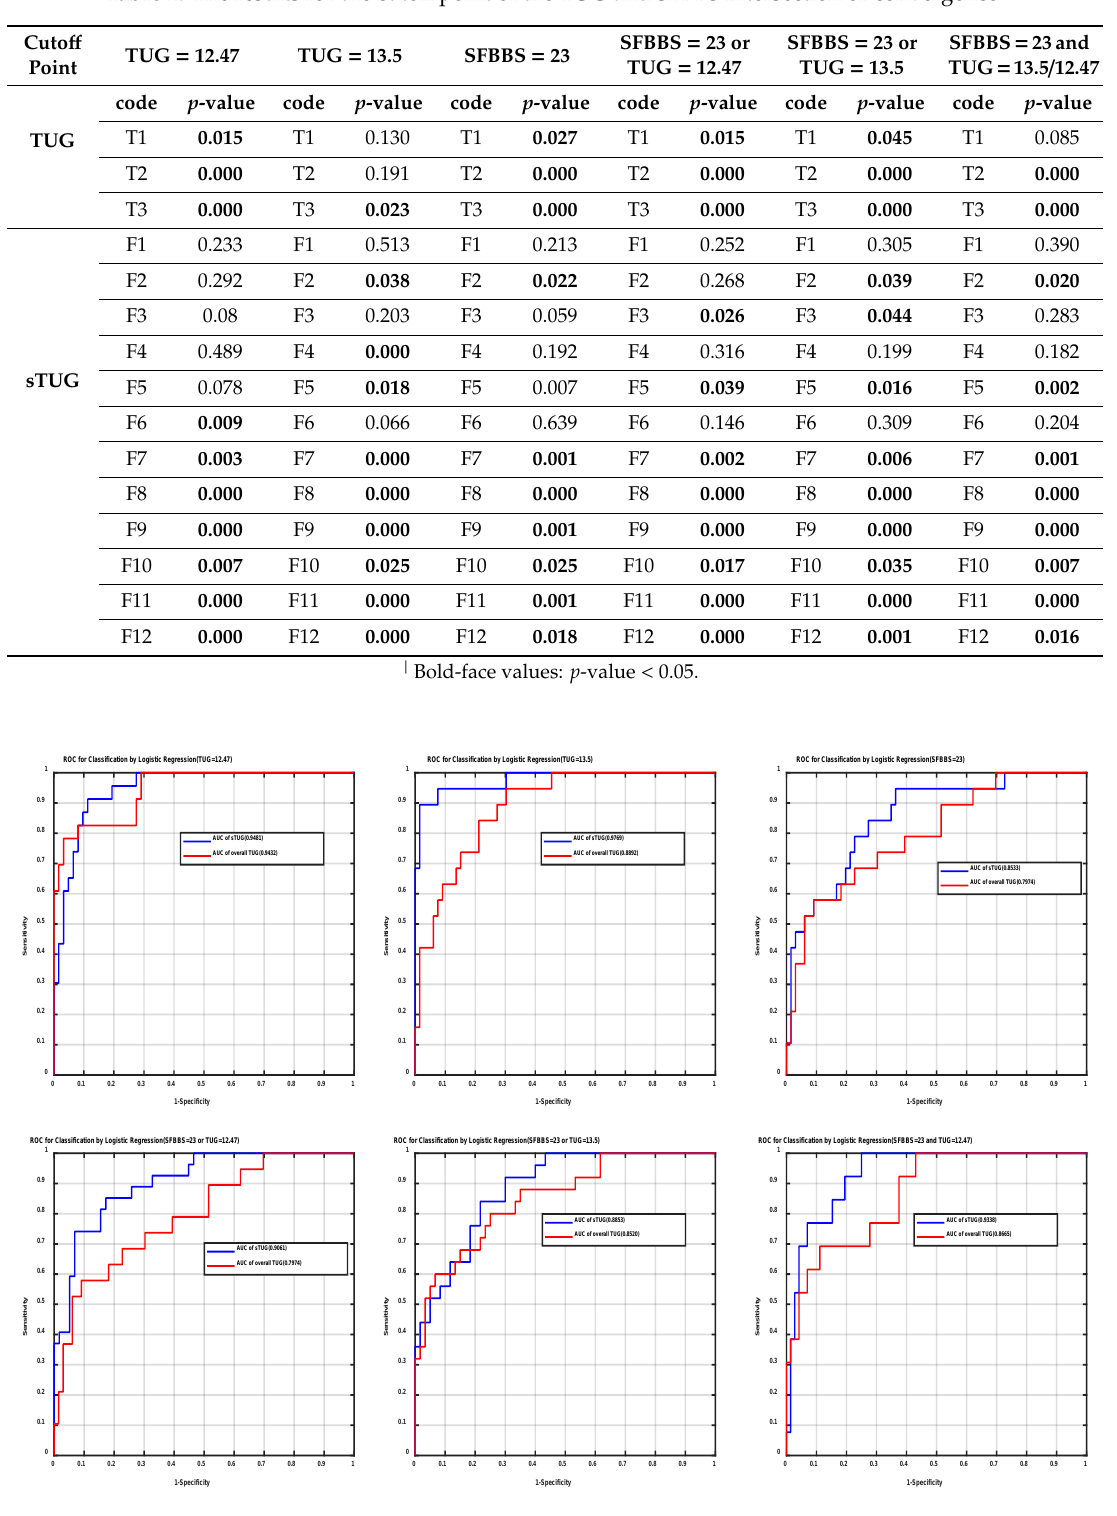
Figure 5. ROC for classification by logistic regression with clinical test and TUG segmentation.